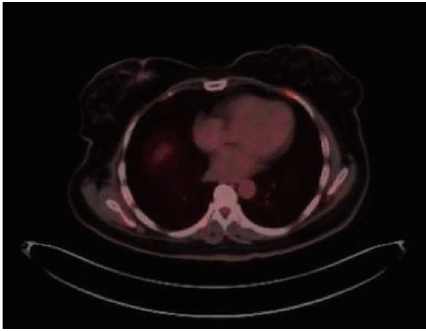
Figure 4: Whole body PET/CT showing right breast suspicious mass.